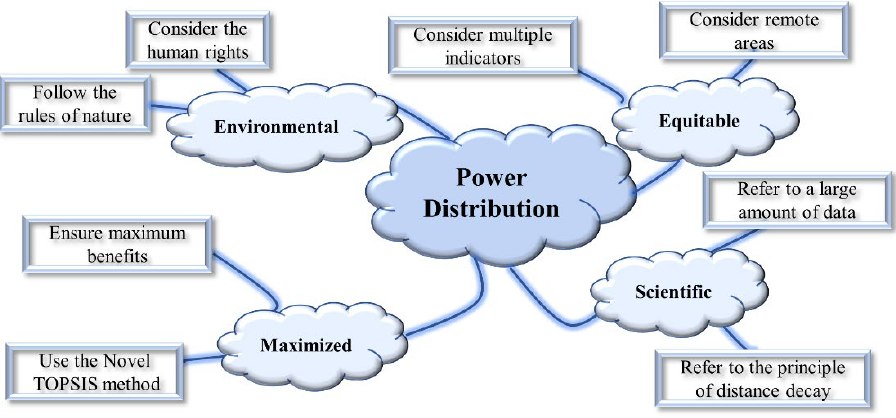
Figure 4. The central idea of power allocation.